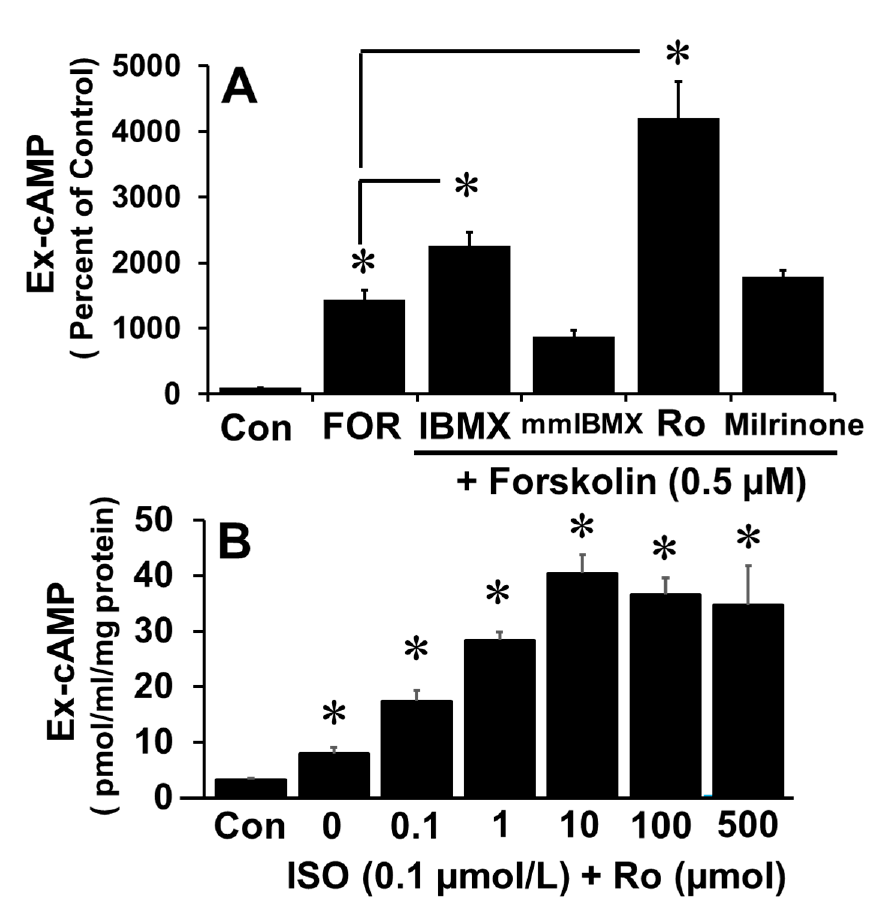
Figure 2. Panel ( A ) depicts bar graph showing the effects of different PDE isoform inhibitors on forskolin-induced increases in extracellular (Ex) cAMP levels after 15 min stimulation with: IBMX (100 µ M); mmIBMX (100 µ M), Ro20-1724 (100 µ M); and milrinone (10 µ M) on cAMP production in response to forskolin (0.5 µ M) by confluent monolayer of FT cells. Panel ( B ) depicts the concentration- dependent modulatory actions of the PDE-IV inhibitor Ro20-1724 (Ro; 0.1–500 µ M) on isoproterenol (0.1 µ M) induced increases in cAMP levels. Data (mean and SEM) represent the mean of three different experiments ( n = 3) in triplicate. Values were normalized to total protein concentration and the cAMP level is expressed as pmol/mL/mg protein or as percent of control (* p < 0.05 vs. control). Treatment of freshly prepared and cultured FT cells (1 × passage) with E2 (0.2–20 ng/mL) significantly increased cAMP levels (Figure 3A). The stimulatory effects of E2 on cAMP levels were significantly enhanced in the presence of the adenylyl cyclase activator forskolin (0.5 µ M) and these effects were concentration-dependent (Figure 3B). Time-dependent (0–180 min; Figure 3C) stimulatory effects of E2 on levels of cAMP were also observed in FT cells treated simultaneously with IBMX (1 µ M; p < 0.05 vs. IBMX alone). Furthermore, treatment for 180 min with E2 increased cAMP levels; and this response to E2 was greater in the presence of IBMX (Figure 3D) or Ro20-1724 (Figure 3E). The fact that the stimulatory effects of E2 on cAMP generation were rapid suggests the involvement of a non-genomic mechanism. To assess whether these effects were mediated via membrane ERs, the effects of E2-BSA (a non-permeable ER agonist) were compared with E2. Indeed, treatment with E2-BSA induced cAMP in FT cells and the stimulatory effects of E2 and E2-BSA did not differ (Figure